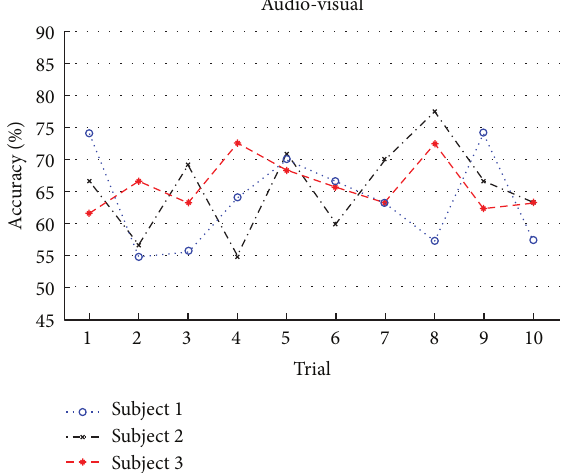
Figure 6: Classification accuracy of the audio and visual stimuli.